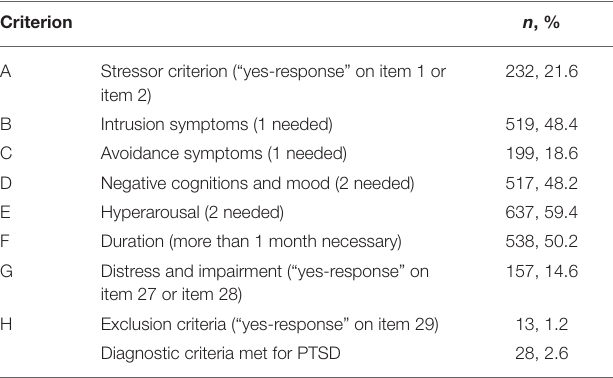
TABLE 2 | Assessment of PTSD with the City BiTS using DSM-5 diagnostic criteria ( N = 1,072). Criterion